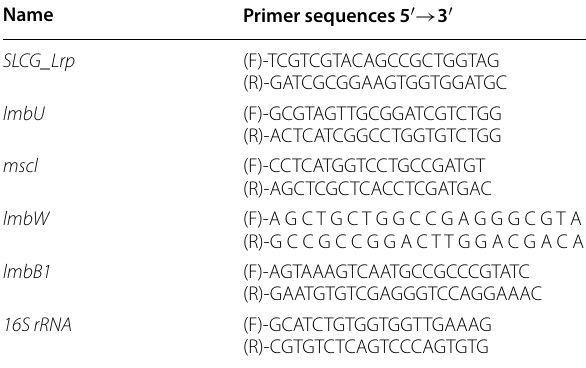
Name Primer sequences 5 ′